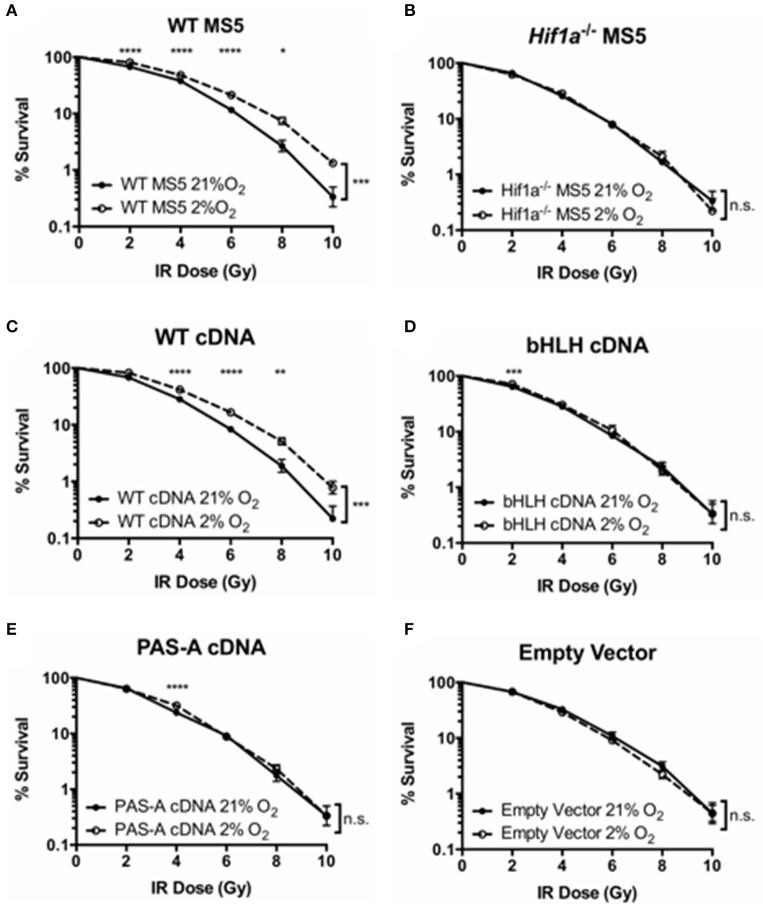
Effect of Hif-1α cDNA mutants on MS5 radio-resistance. Clonogenic survival assays of (A) WT MS5 cell line, (B) Hif-1α−/− MS5 Clone 41 cell line, (C)
Hif1a−/− MS5 Clone 41 cell line transduced with a WT Hif-1α cDNA lentiviral construct, (D)
Hif1a−/− MS5 Clone 41 cell line transduced with a bHLH-mutated Hif1a cDNA lentiviral construct, and (E)
Hif1a−/− MS5 Clone 41 cell line transduced with a PAS-A-mutated Hif1a cDNA lentiviral construct, and (F)
Hif1a−/− MS5 Clone 41 cell line transduced with an empty lentiviral construct, cultured in 21 or 2% O2. *p < 0.05, **p < 0.01, ***p < 0.001, ****p < 0.0001 compared with normoxic samples, two-way ANOVA with Bonferroni post-test correction for the multiple comparisons, n = 9.